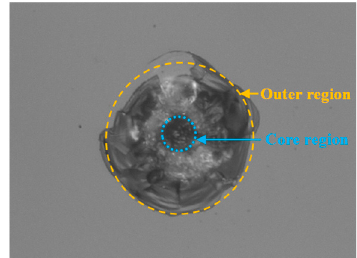
Figure 4. Optical microscopic image of a typical damage site on fused silica exit surface induced by a nanosecond pulse at 355 nm. The core region and the outer region of the damage site are indicated by blue and orange dashed circles, respectively.